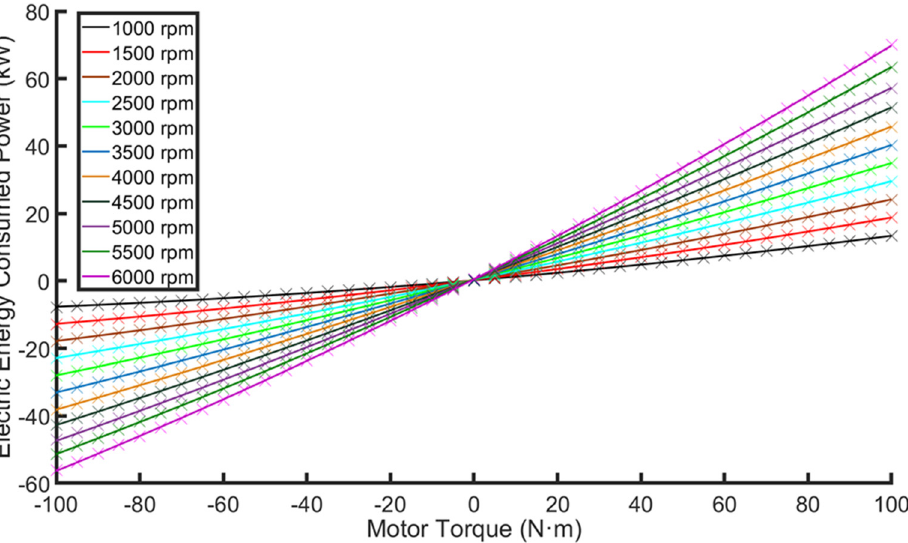
Figure 3. Fitting results of the electric energy consumed power.